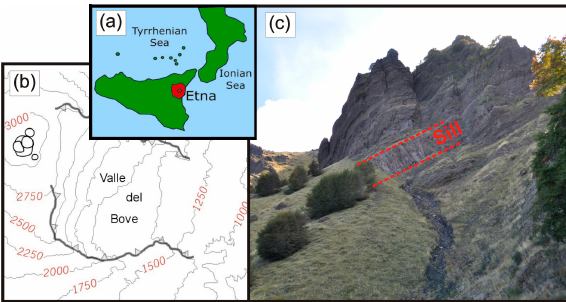
Figure 1. Schematic map showing the location of Mt. Etna volcano ( a ), Valle del Bove depression ( b ) sill formation ( c ). ( b ) sill formation ( c